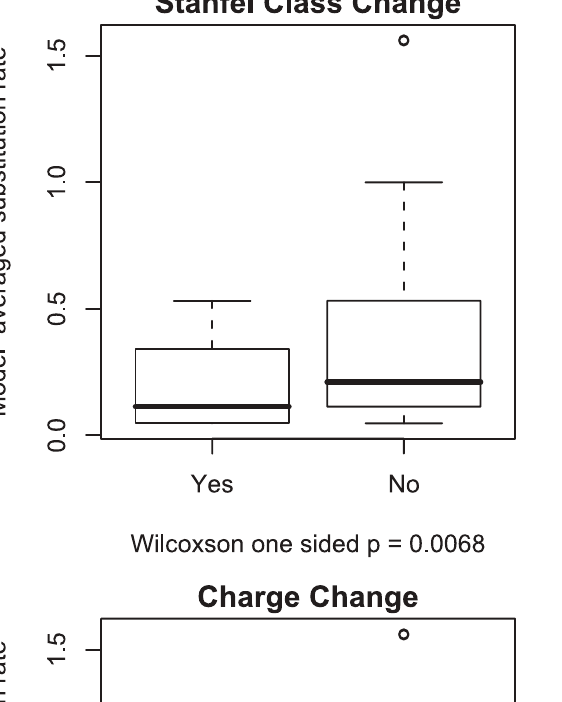
Figure 5. Evolutionary rate clusters in structured GA models ( GA s ) inferred from the vertebrate rhodopsin protein alignment. Each cluster is labeled with the maximum likelihood estimate of its rate inferred under GA s . The residues (nodes) are annotated by their biochemical properties and Stanfel class, and the rates (edges) are labeled with model-averaged ( GA r ) rate estimates. The style of an edge is determined by its cluster affinity, where high cluster affinities indicate that a large proportion of models in the credible set were consistent with the structured GA s model.